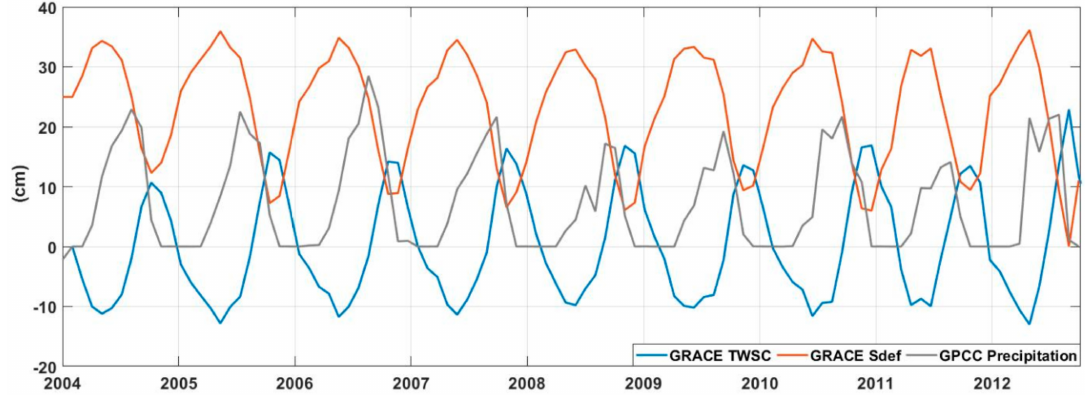
Figure 7. Variations in time series of monthly GRACE TWSC, storage deficit and precipitation for longitude 12.5 and latitude 9.5 from 2004 to